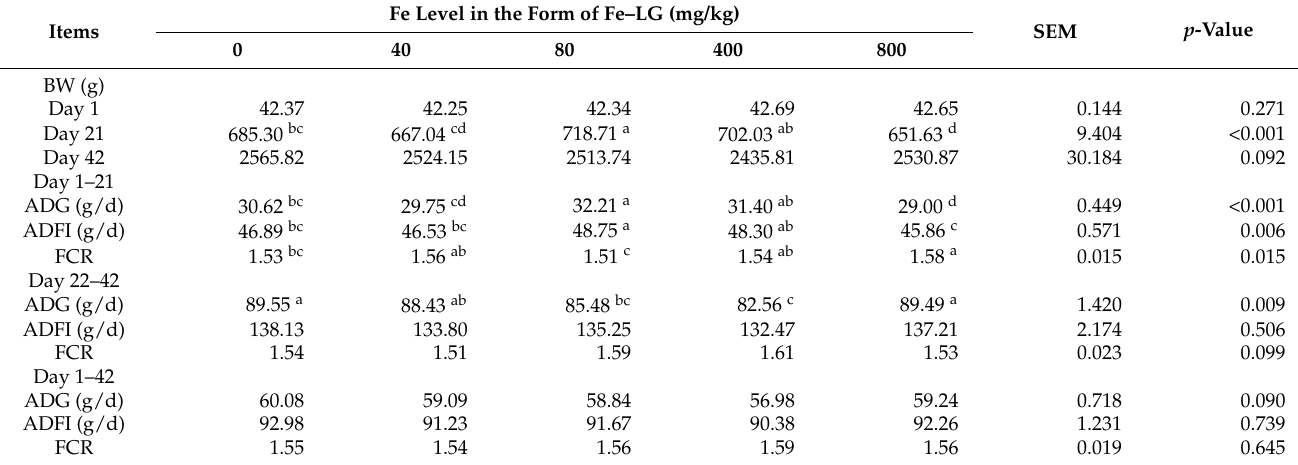
Table 6. Effects of dietary supplementation with high doses of Fe–LG on growth performance of broilers 1